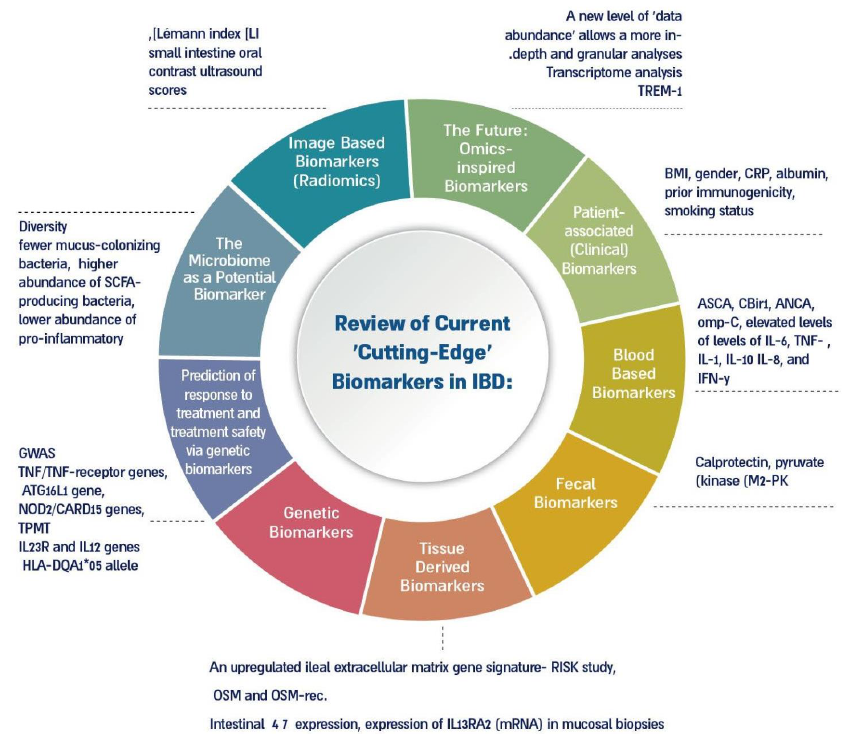
Figure 2. A schematic diagram depicting the current and future potential, multilayered, ‘state-of- the-art’ biomarkers utilized in IBD, categorized by origin and source of the biomarker. art’ biomarkers utilized in IBD, categorized by origin and source of the 8. Integrating Biomarkers in Everyday Clinical Practice—Reality or Wishful Thinking